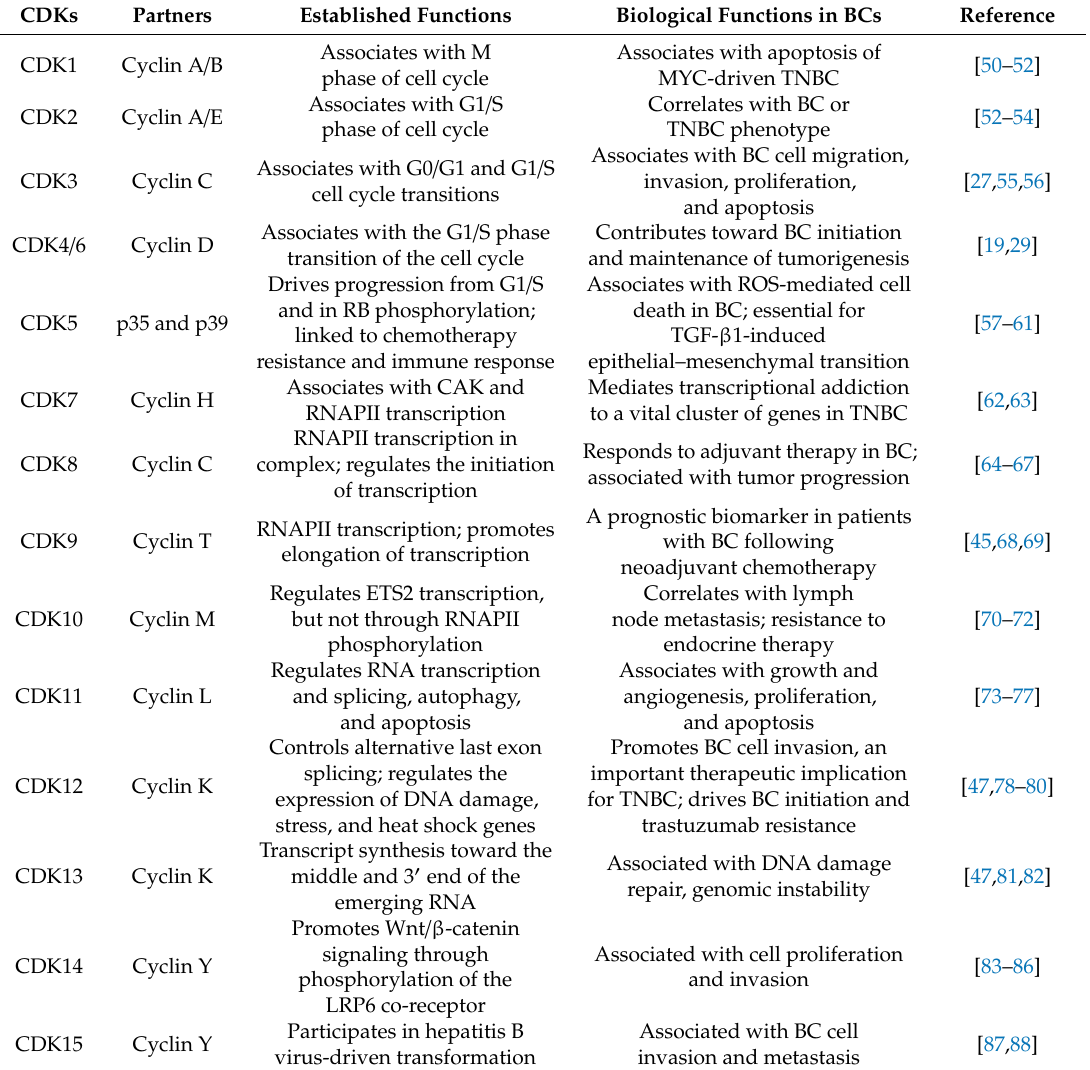
Table 1. Summary of the biological functions of CDKs in